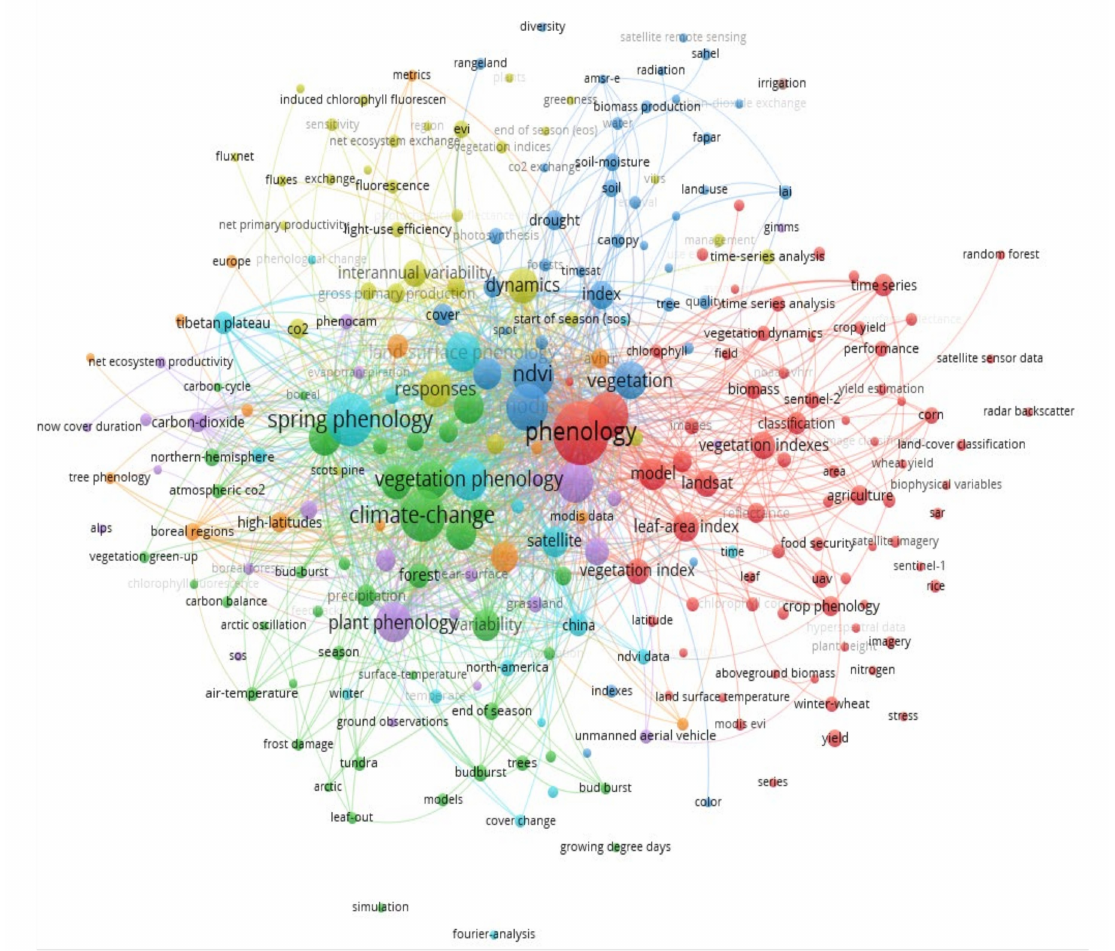
Figure 3. Link analysis of